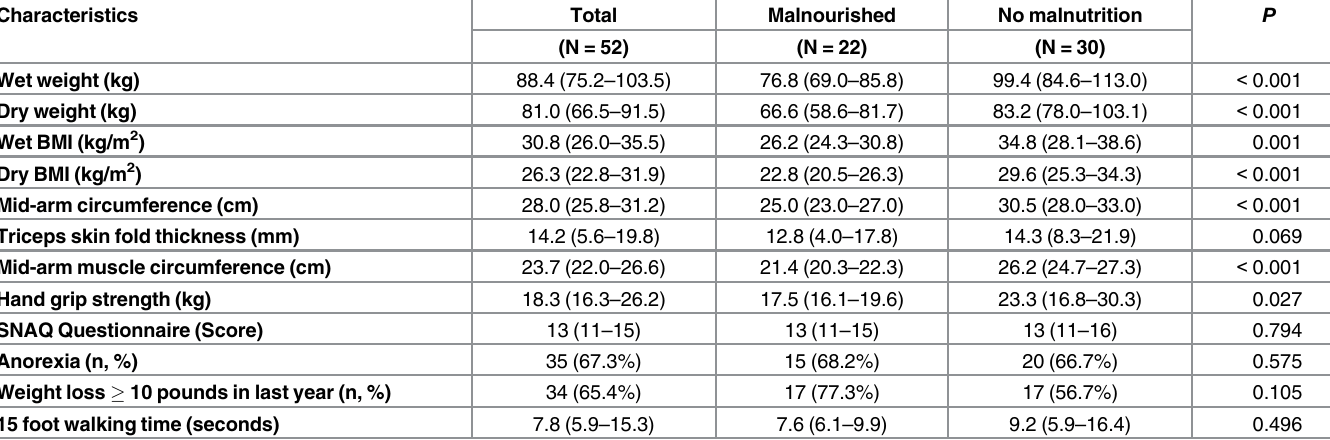
Table 2. Anthropometric, Functional, and Nutritional Features of